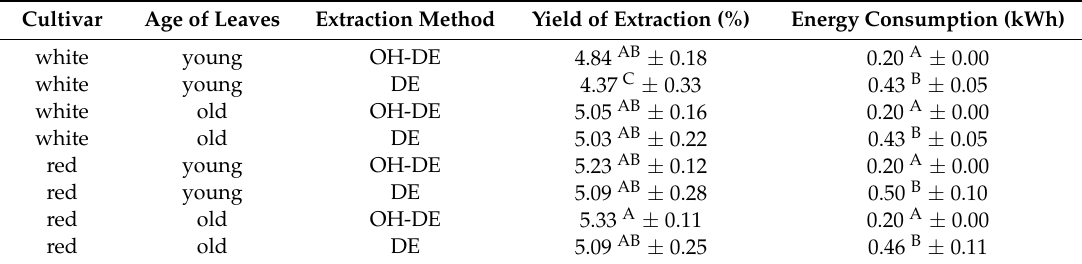
Table 2. Yield of extraction (%) and energy